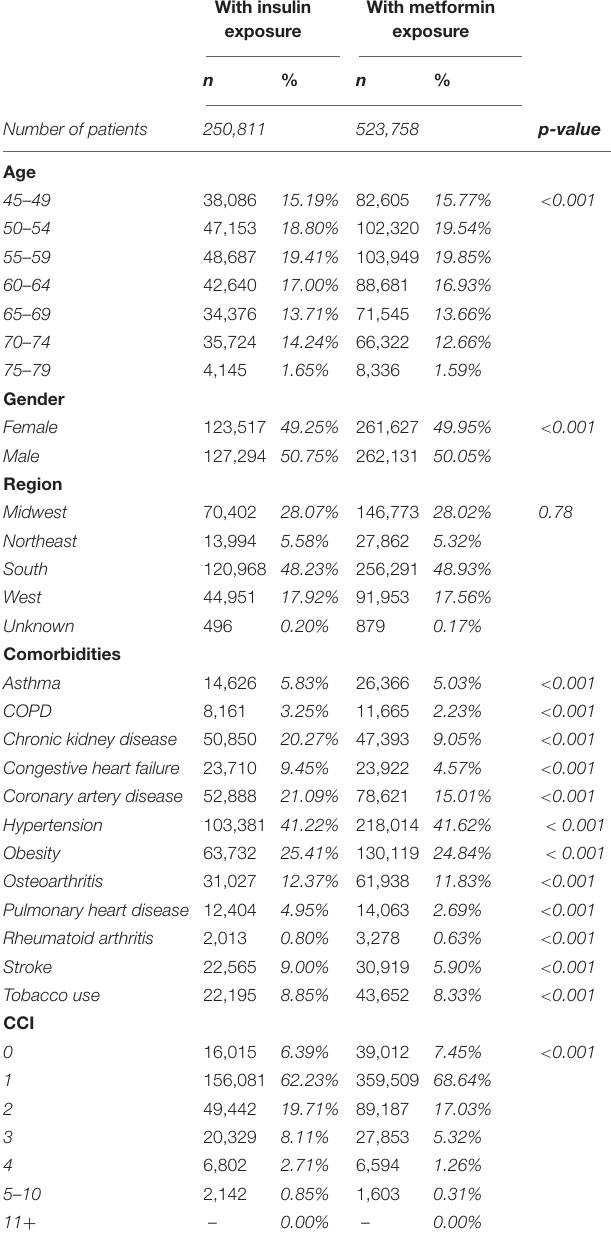
TABLE 7 | Patient demographics and comorbidities in patients treated with insulin in comparison with patients treated with metformin. With insulin With metformin exposure